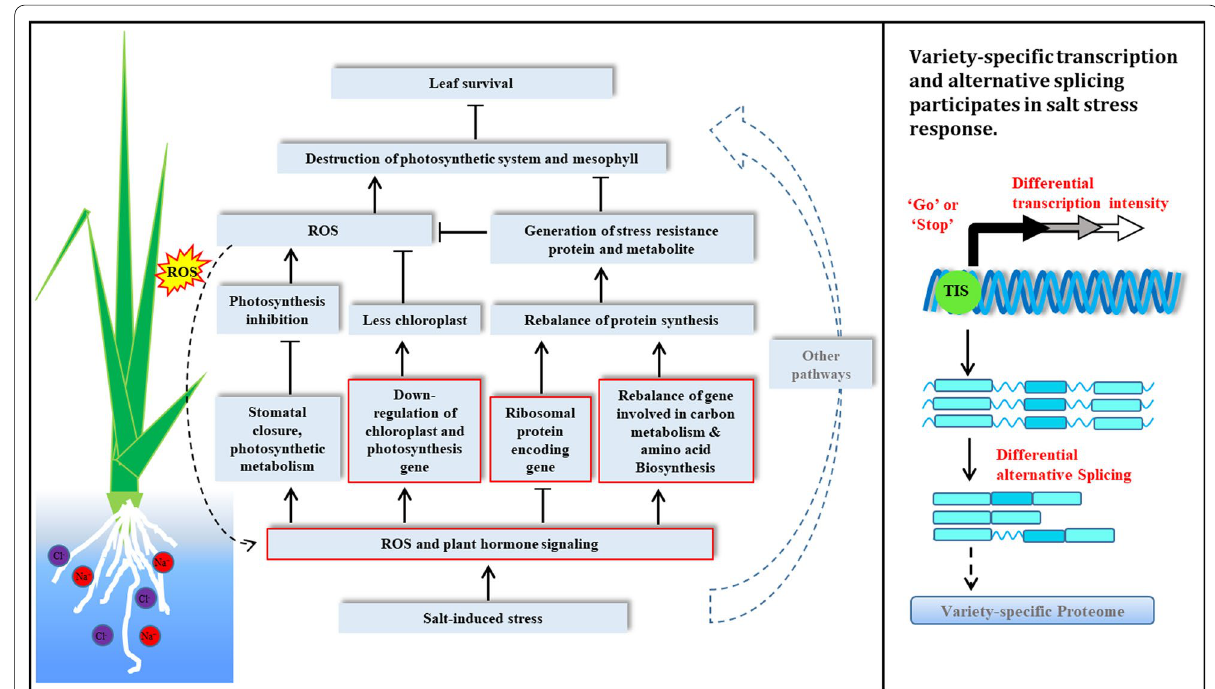
Fig. 9 A landscape of molecular response in rice leaves at early stage of salt stress. The left panel: The salt treatment induced water shortage, ABA signaling and ROS burst. These signals would affect upper part of rice plants through several different pathways after several hours of salt stress. (1) ABA and ROS transports to leaves and close stomata and disturb photosynthetic metabolism, which will cause over excessive generation of ROS, and subsequently destroy the membrane system of cells if the ROS cleavage system does not function efficiency, finally make cell death and leave senescence (Apel and Hirt 2004; Chaves et al. 2009; Hu et al. 2020). (2) At early stage of salt stress, water shortage triggered ROS burst down regulated chloroplast development and photosynthetic components (Formentin et al. 2018), which will subsequently reduce photosynthesis activity in leaf cells, and then reduce the ROS accumulation (Huang et al. 2009; Ponce et al. 2021; Wang et al. 2021). (3) ROS and ABA and other plant hormone signaling turn down the ribosome, which is responsible for protein synthesis. Reduction protein synthesis will reduce energy consumption of the plants (Moin et al. 2021). However, basic protein synthetic activity is still necessary, because stress proteins are required for stress tolerance. (4) Genes involved in carbohydrate and amino acids metabolism were regulated to a new balance status after sensing the ROS, ABA and other hormone signals (Ponce et al. 2021). This pathway and (3) participates in regulation of protein biosynthesis, modulating abundance of stress proteins, such as ROS cleavages (Ponce et al. 2021). The integrated regulations in different pathways at early stage of salt stress may finally control longevity of leaves under continuous salt stress conditions (Hu et al. 2020). Other regulations not discussed here could also found from (Ponce et al. 2021). The right panel: Expressions of genes responsible for these modulations could be regulated through a variety-specific manner on both transcriptional and mRNA splicing